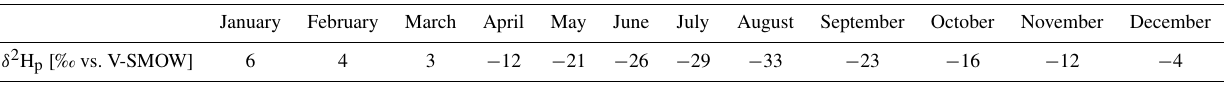
Table 1. Modelled isotopic hydrogen composition of precipitation at Voëlvlei (latitude: 34.013 ◦ S; longitude: 22.904 ◦ E; elevation: 5m) (Bowen, 2018; Bowen et al.,